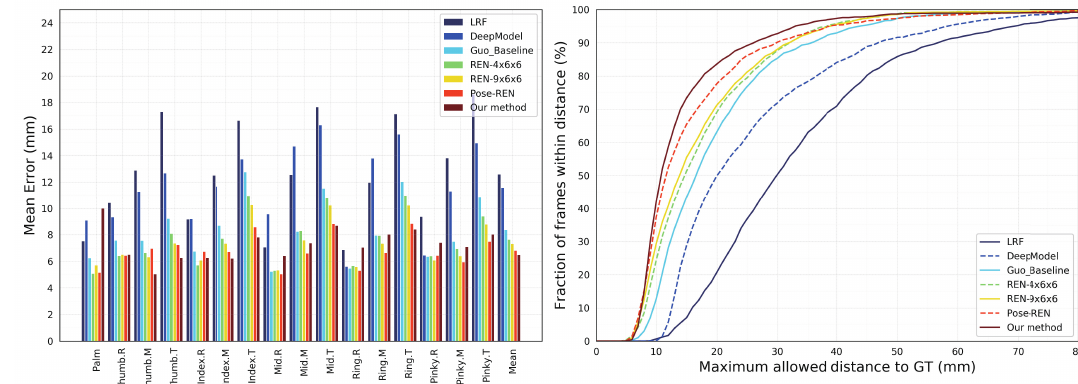
Figure 5. Our approach compares the latest benchmarks on ICVL dataset. Left : Each joint error. Right : The fraction of frames over different maximum Euclidean distance error thresholds. The large area below the curve indicates better results. Our proposed method performs best in the graph of discriminating methods. (Best viewed on